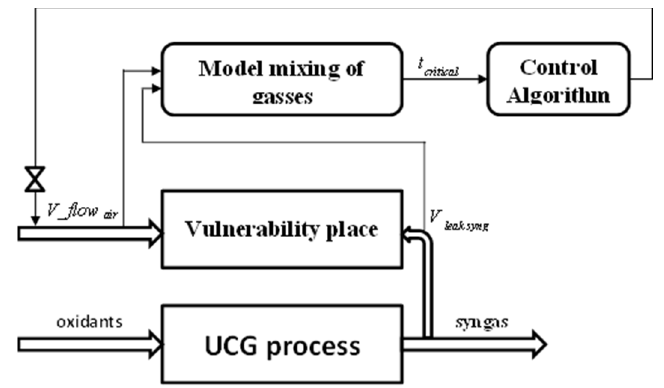
Figure 10. The principle diagram of the control process.